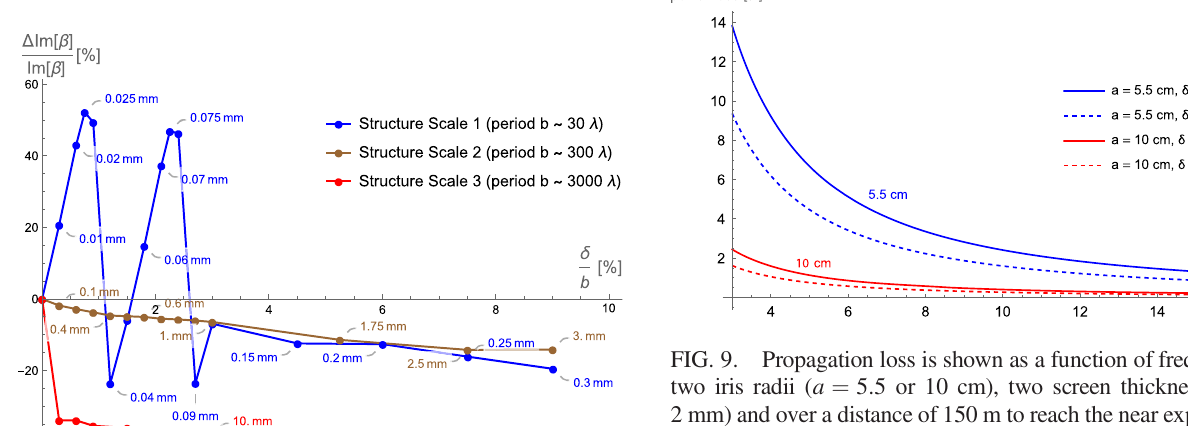
prediction with the Vainstein-based predictions for δ ¼ 0 screens, the table shows the effect of increased screen thickness (varying δ ) on the attenuation constant (Im ½ β 0 (cid:2) ),